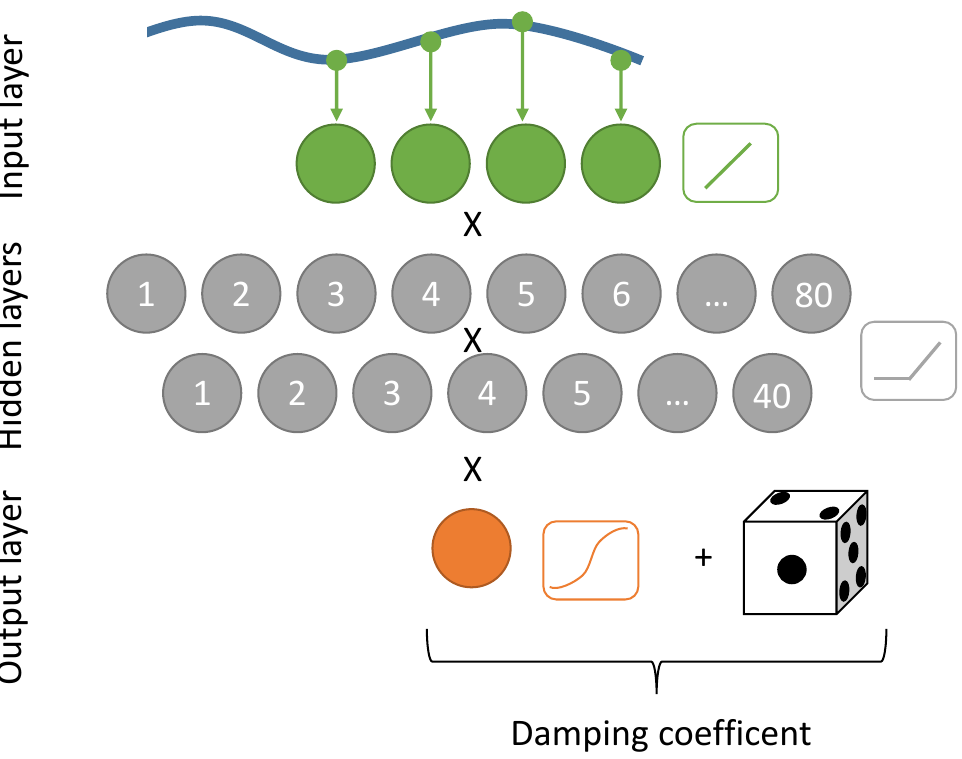
Figure 5. Number of layers and neurons for the collaborative learning network 2 (CL-ANN2).